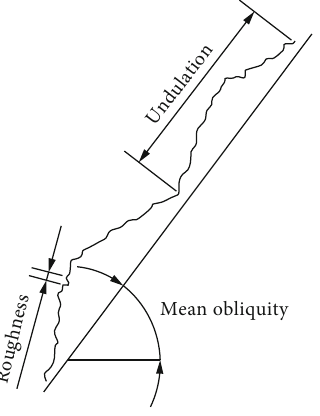
Figure 7 : Roughness and undulation of structural